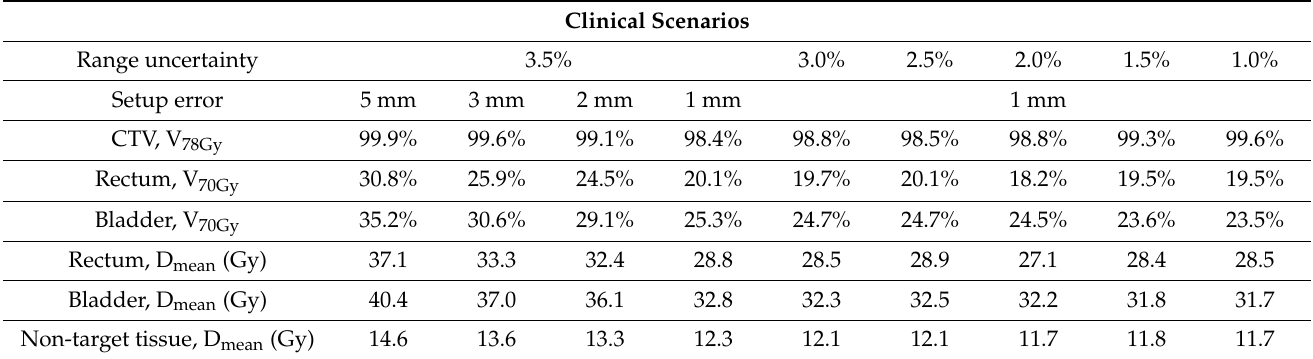
Table 1. Comparative effects of simulated robust optimization uncertainties in proton beam range and setup on dosimetry in a prostate intensity-modulated proton therapy (IMPT) planning